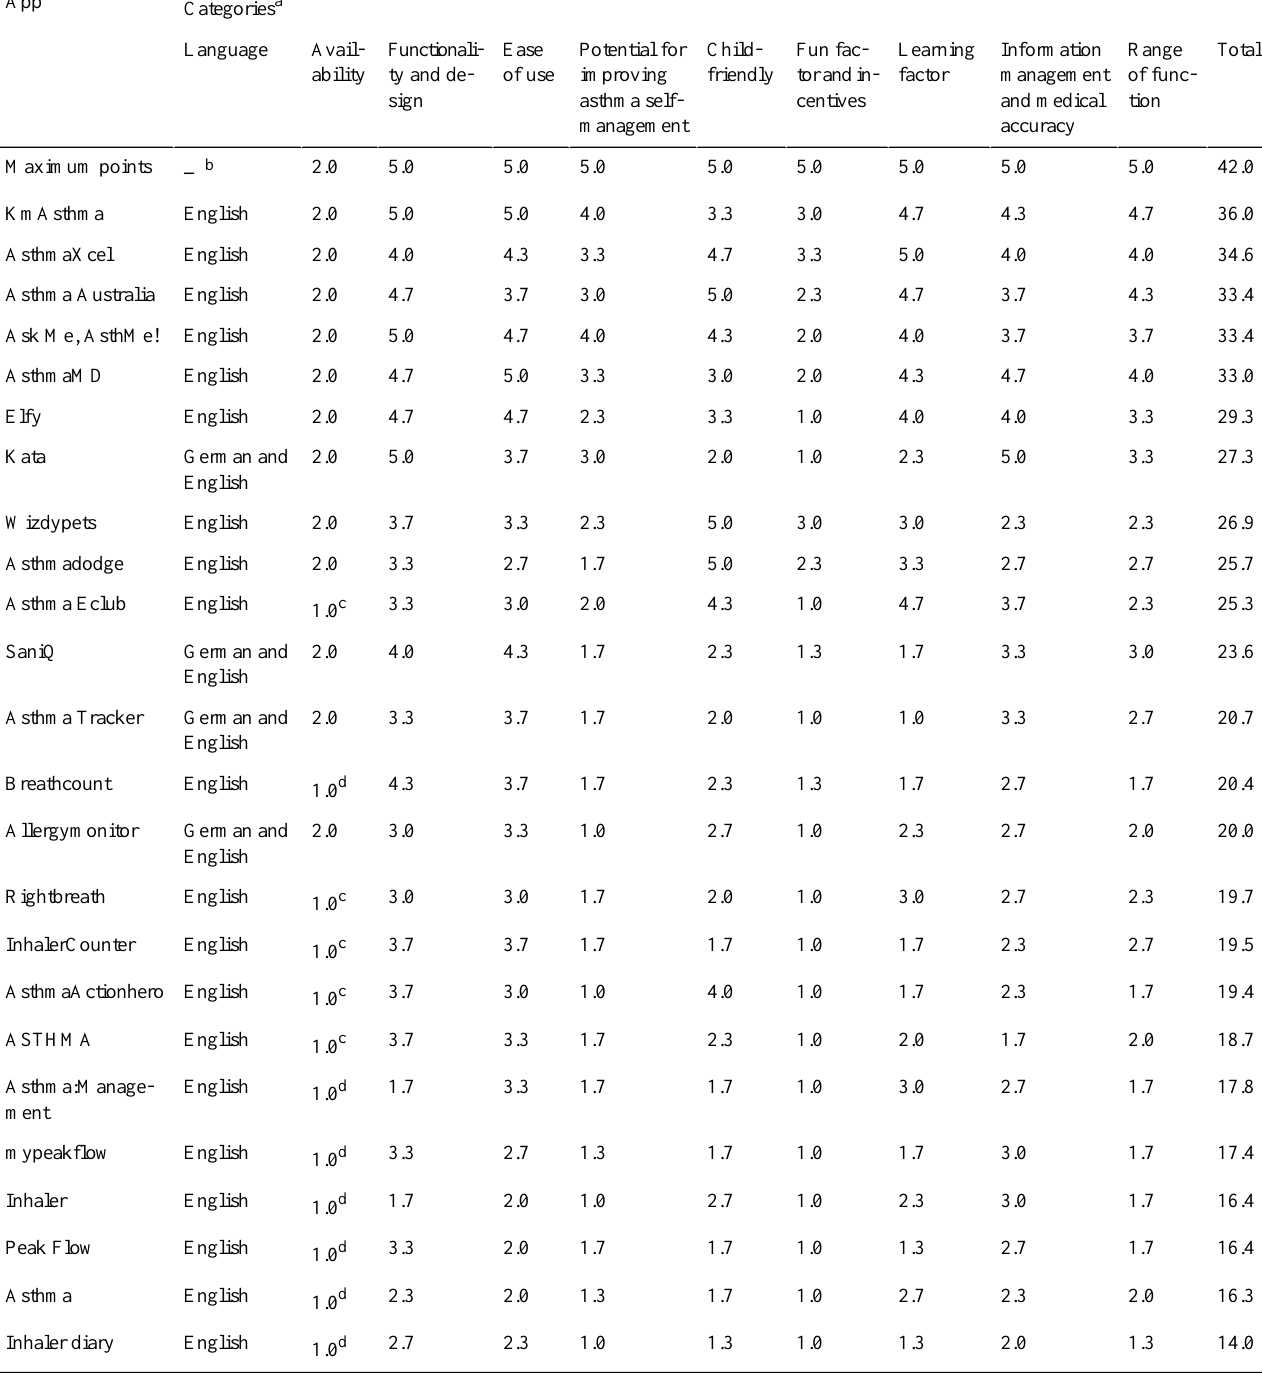
Table 2. Average of the 3 testers’evaluation (individual categories and overall points of English and German language